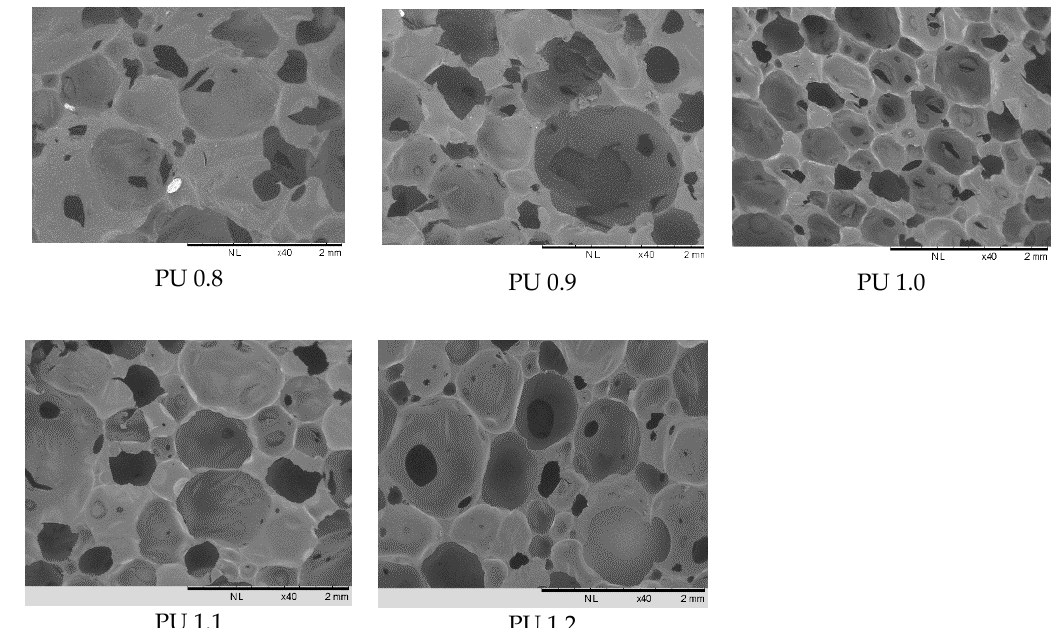
Figure 4. SEM images of polyurethanes produced by different isocyanate indices (40× magnification) * PU 0.8, PU 0.9, PU 1.0, PU 1.1, PU 1.2 were prepared by reacting palm oil-based polyester polyol with IPDI at isocyanate index of 0.8, 0.9, 1.0, 1.1 and 1.2.